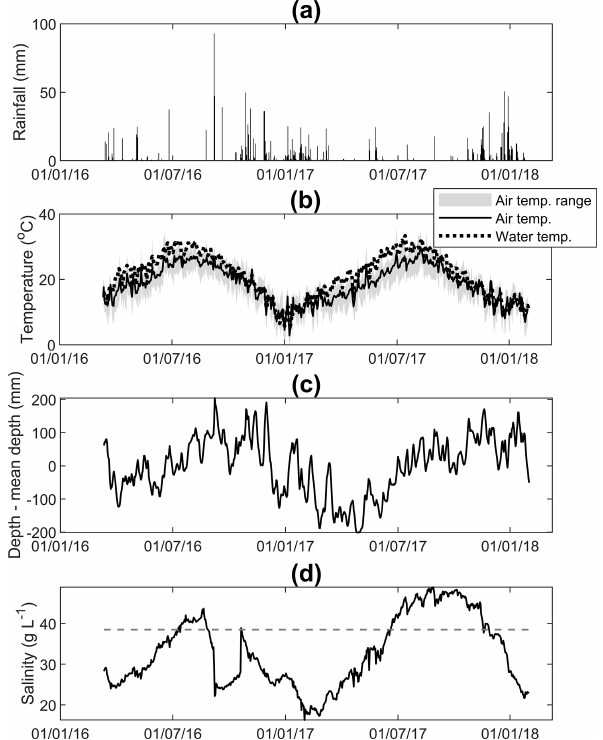
Figure 2. Time series of (a) daily total precipitation, (b) daily mean air and lagoon water temperatures (solid and dashed curves, respec- tively), daily air temperature range (shaded area), (c) lagoon water depth (normalized by the mean depth), and (d) salinity.